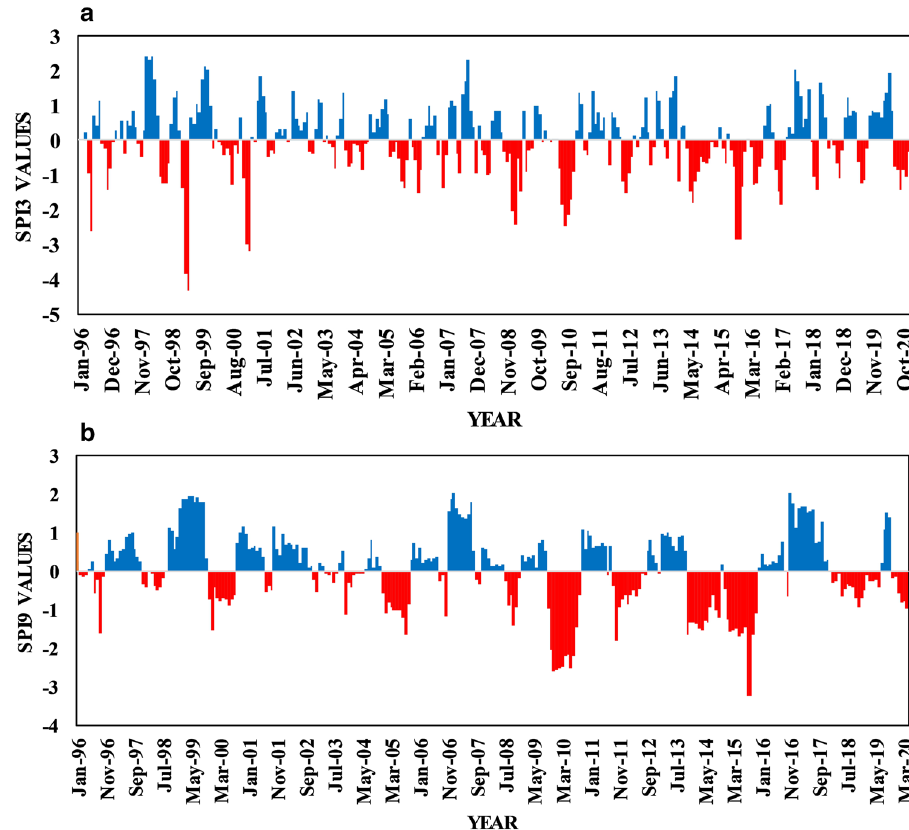
Fig. 7 Standardized precipita- tion index (SPI) values in differ- ent time scale, a 3 month time